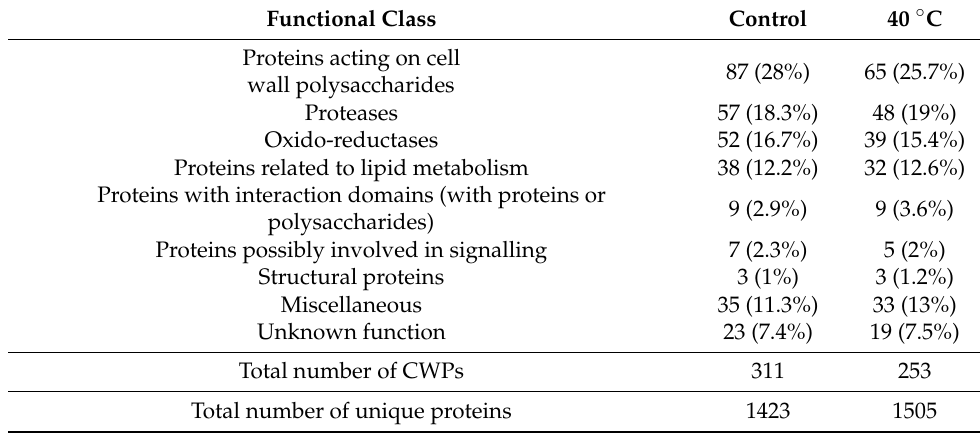
Table 1. Number of unique proteins and CWPs that were identified for the control and 40 ◦ C and classified into the functional classes (classified as in WallProtDB ). The percentage of the proteins identified in the functional classes compared to the total number of CWPs for each treatment is indicated in